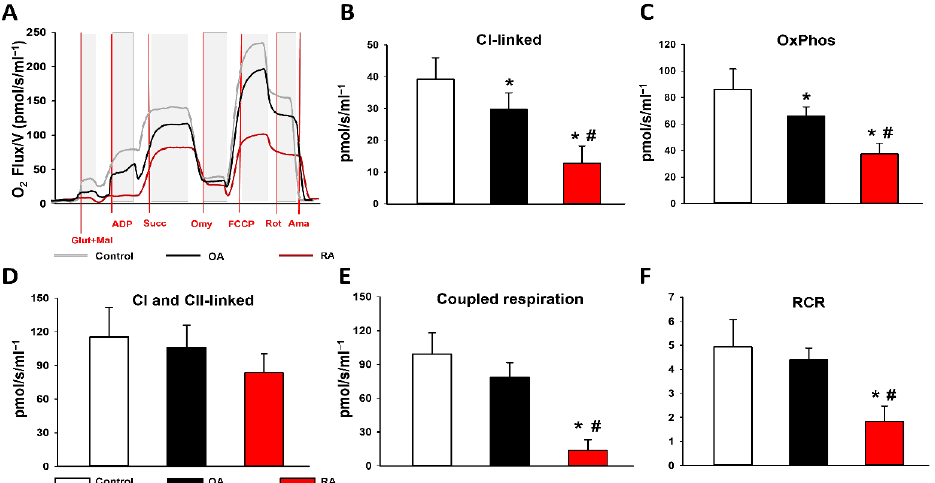
Figure 1. Mitochondrial functional measurements. ( A ) Representative records of mitochondrial ox- ygen consumption measured by HRR. ( B ) Complex I (CI) linked (NADH-generating substrates: glu- tamate (Glut) and malate (Mal)-dependent) respiration. ( C ) OxPhos (ADP-dependent) respiration in the presence of saturating levels of substrates. ( D ) CI and complex II (CII)-linked (added succinate